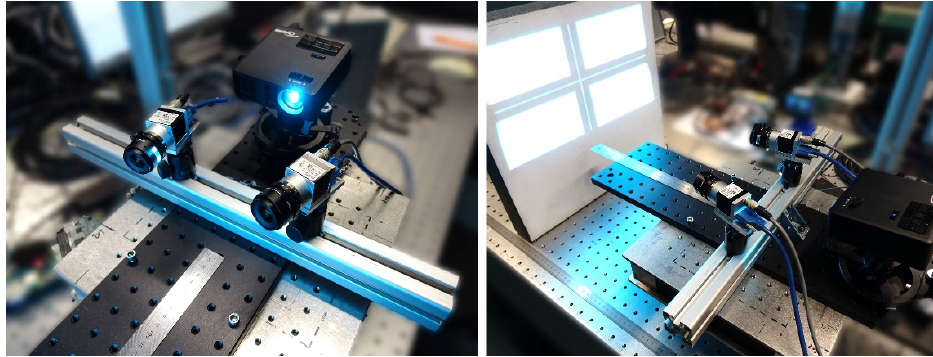
Figure 7. Laboratory setup with projector (left) and setup with plane stone slab (right).